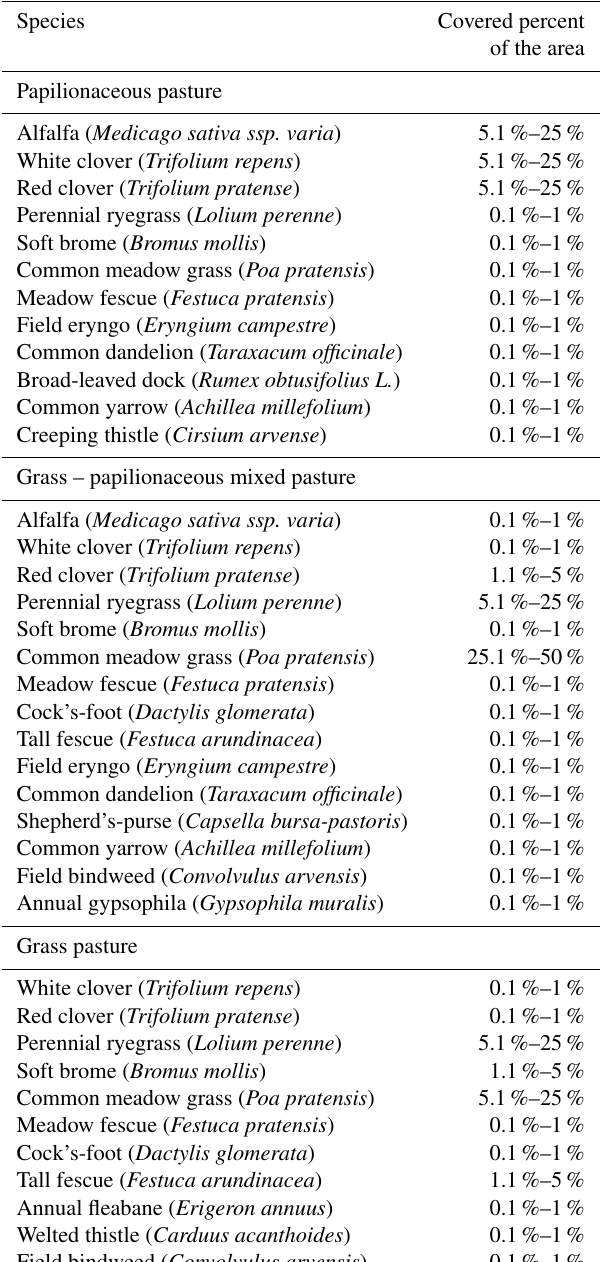
Table 1. Feed coenological composition of the three experimental pastures.